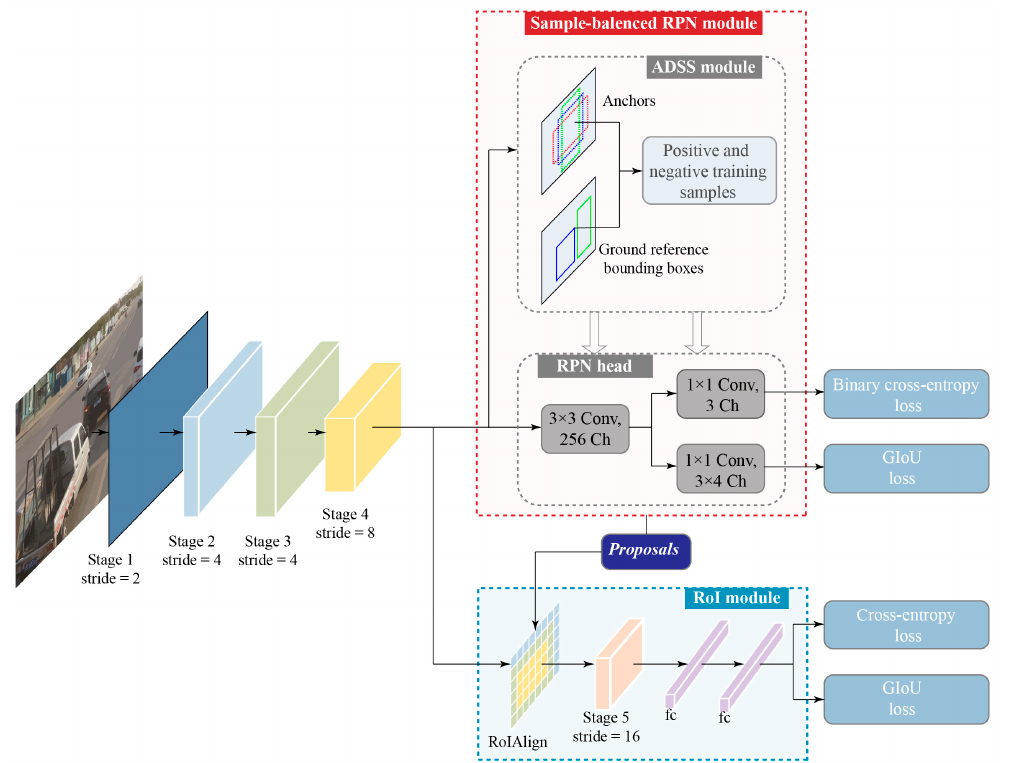
Figure 1. Overall framework of the proposed method.